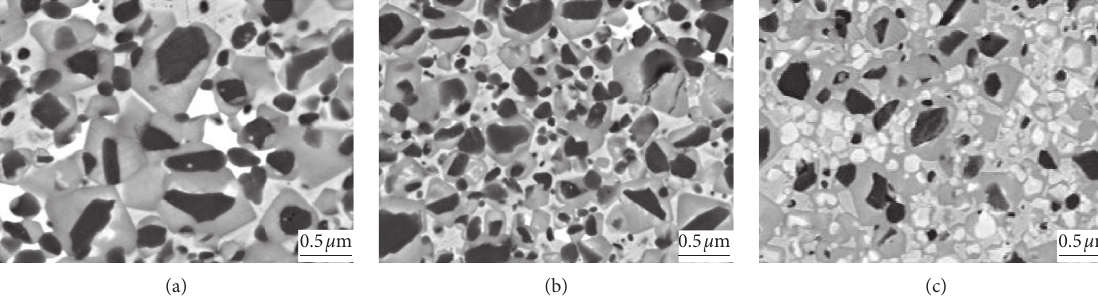
Figure 8: BSE morphology of Ti(C, N)-based cermets: (a) ordinary cermet, (b) added β -Co powder, and (c) added W Mo, Ta (C, N) and β -Co